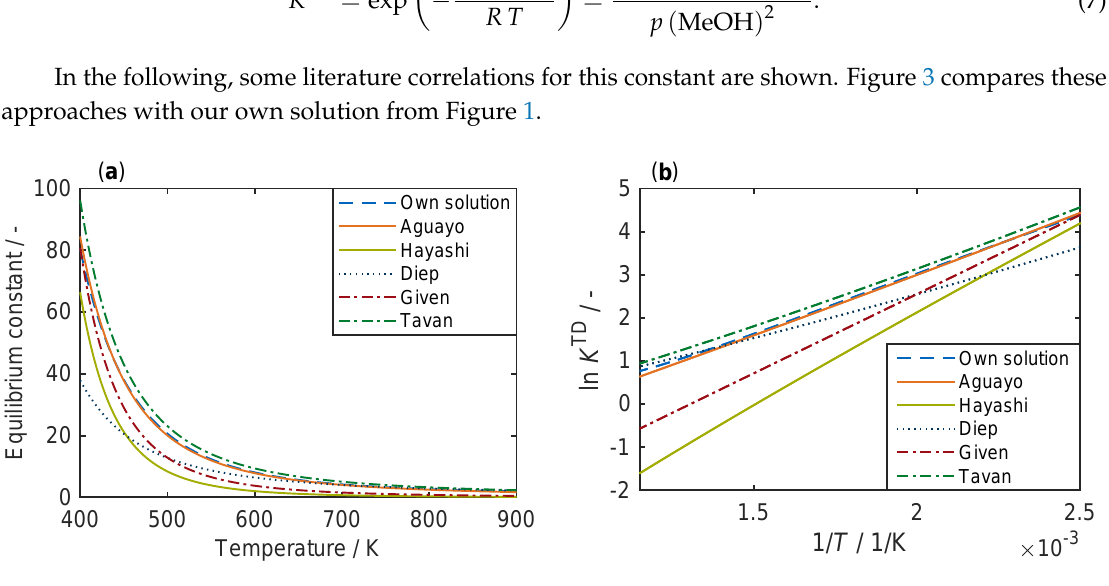
Figure 2. Composition of an equilibrated mixture for C = 650K; and ( b ) as mole fraction of propene at equilibrium conditions as a function of both temperature and total pressure.